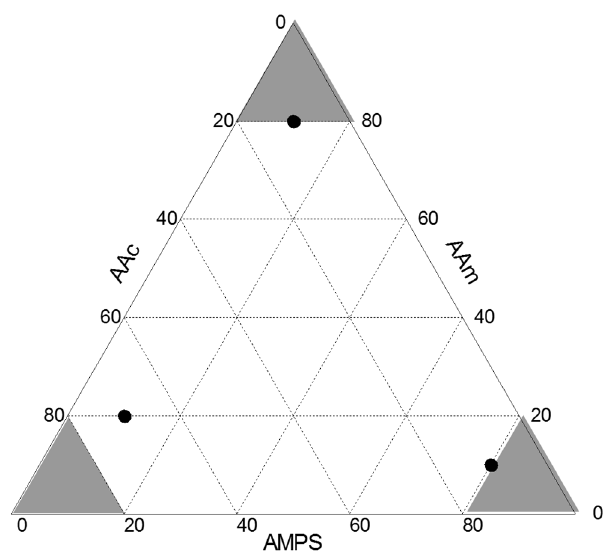
Figure 2. Optimal feed regions and compositions for 2-acrylamido-2-methylpropane sulfonic acid (AMPS)/acrylamide (AAm)/acrylic acid (AAc) terpolymerization.